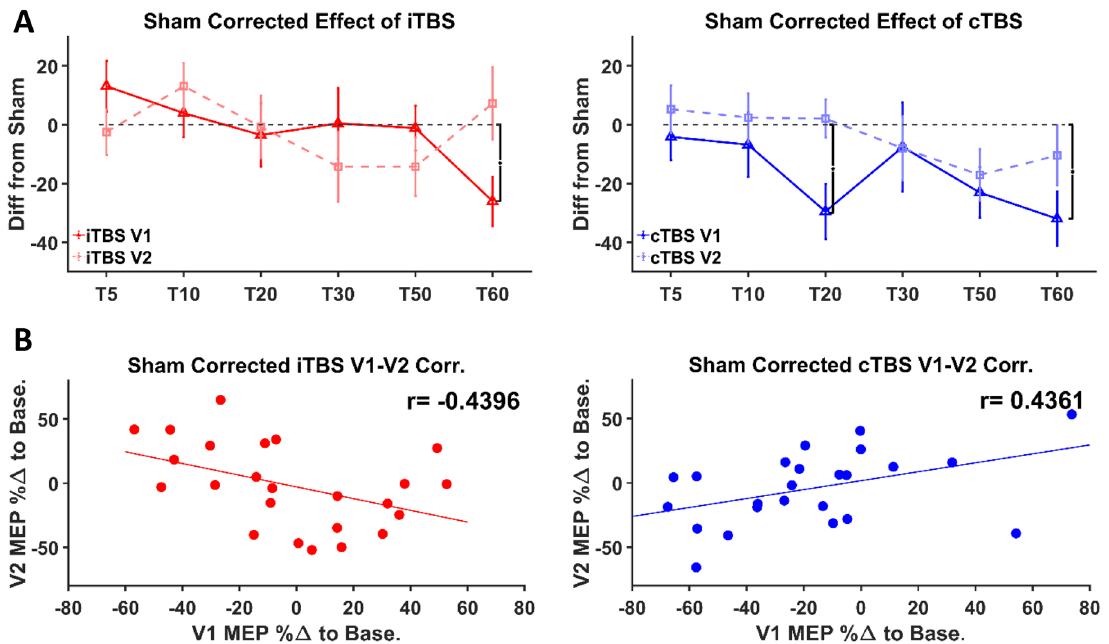
Figure 4. Sham-corrected effect of TBS. ( A ) Left and Right Panel: Group-averaged MEP percentage change from baseline at each time point for each visit with sham TBS subtracted out (from left to right: iTBS and cTBS, respectively). Error bars denote ×2 standard error of the mean. Brackets indicate a significant difference (i.e. p < 0.05) between a TBS protocol at V1 from baseline (i.e. 0, indicated by grey dotted line). ( B ) Left and Right Panel: Individual-level scatter plots for each TBS protocol between repeat visits with sham subtracted out (from left to right: iTBS and cTBS, respectively). On the x-axis is the participant’s response at V1 for that TBS protocol averaged across all time points and on the y-axis their response at V2 to that TBS protocol averaged across all time points with the equivalent sham responses subtracted out. Fit lines denote least squares. Abbreviations: Diff from Sham - Difference from sham, MEP %Δ to Base—motor evoked potential percentage change to baseline.